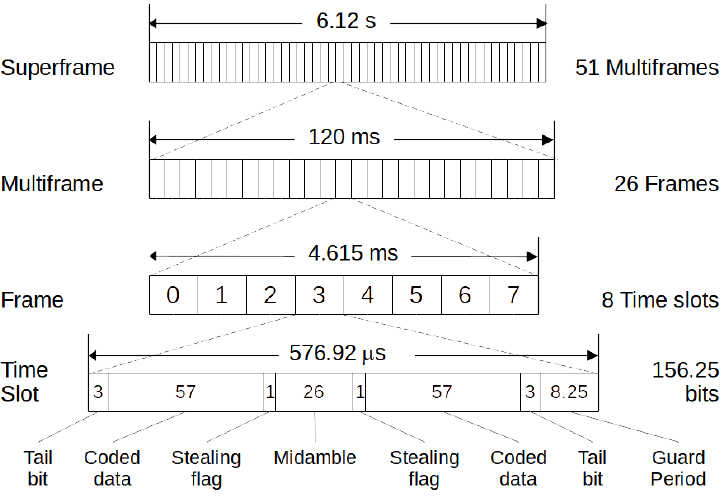
Figure 1. GSM frame structure.